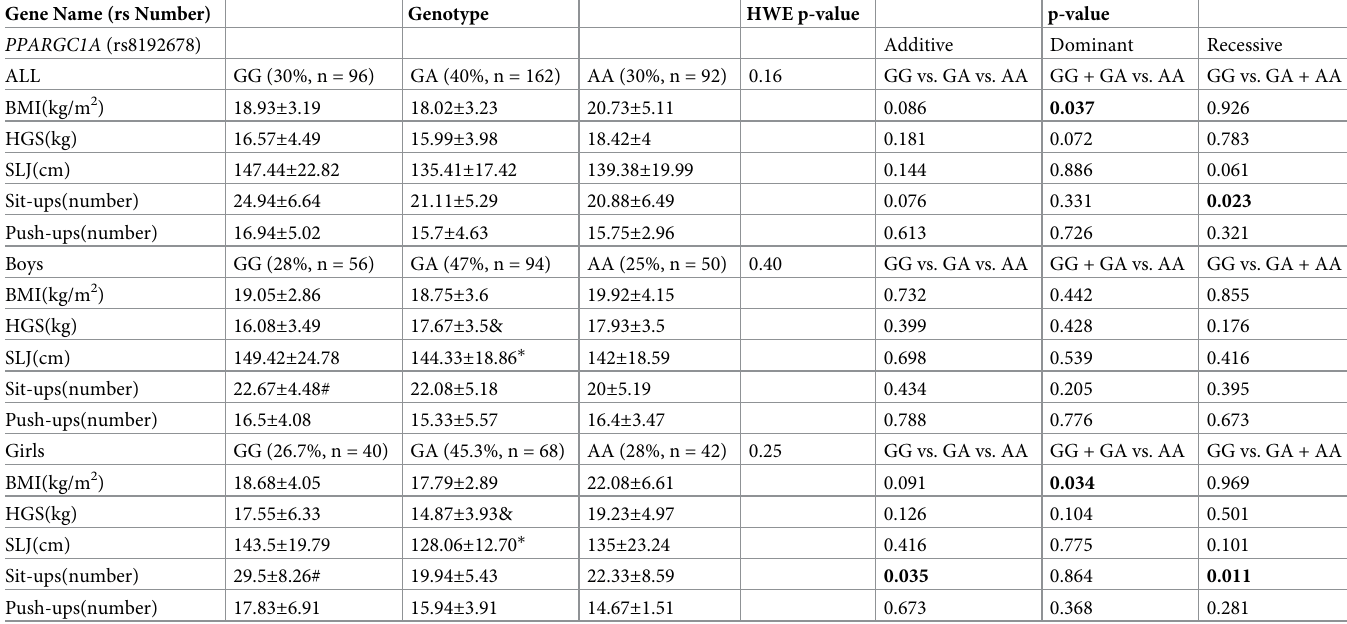
Table 2. Associations of PPARGC1A rs8192678 G/A (Gly482Ser) polymorphisms with HGS, SLJ, sit-ups and push-ups in boys and